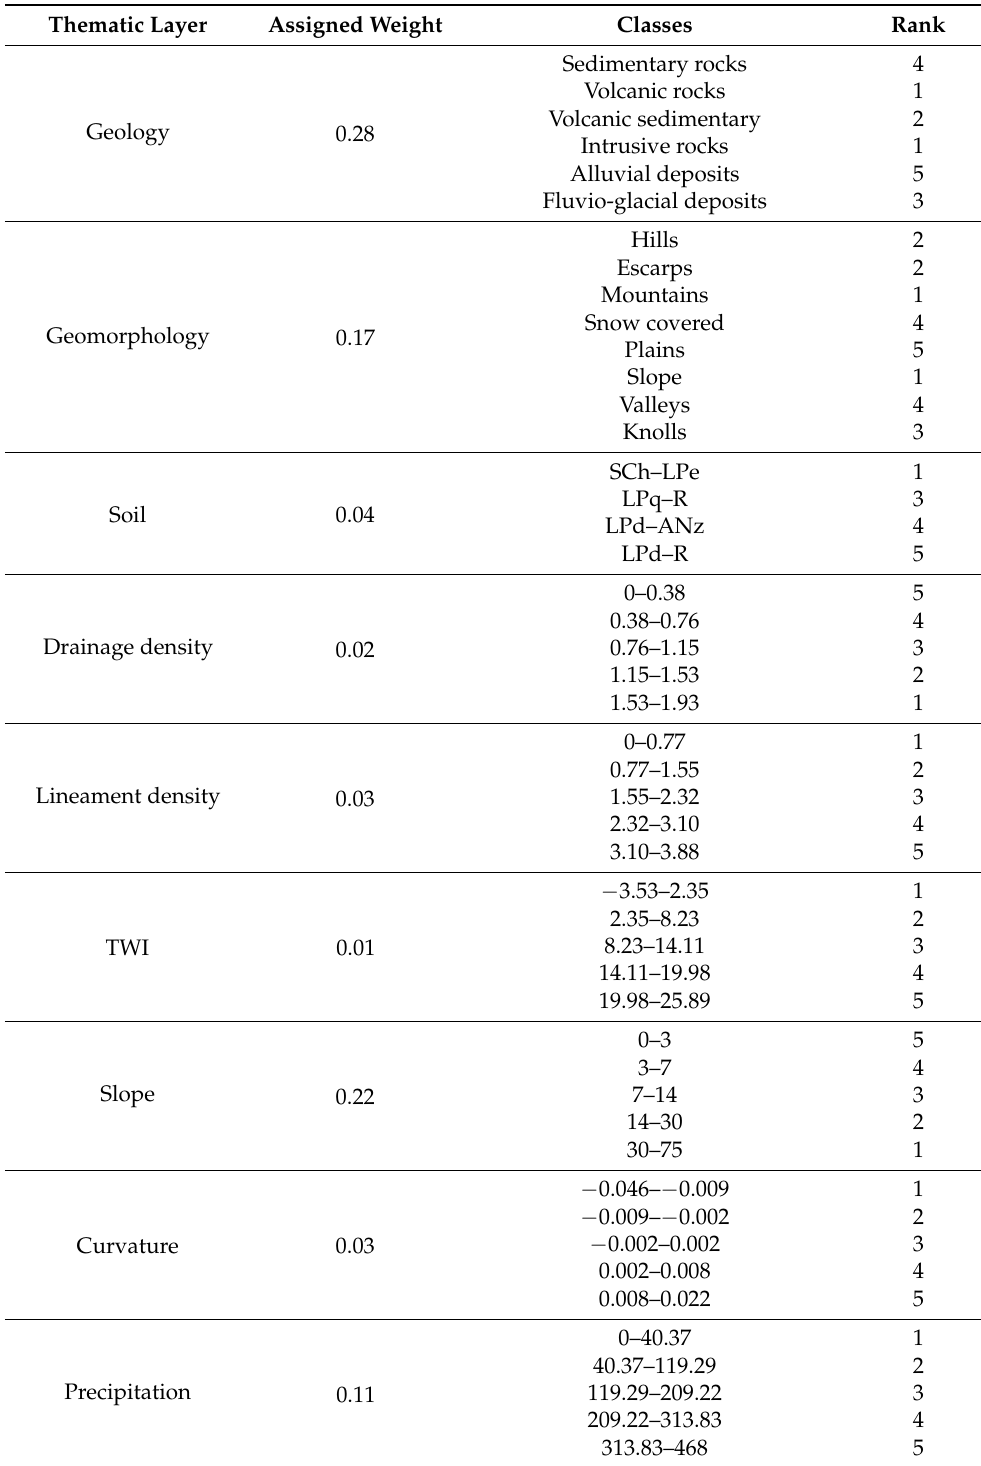
Table 5. Weight assignment and ranking of the subclasses for the thematic layers. Thematic